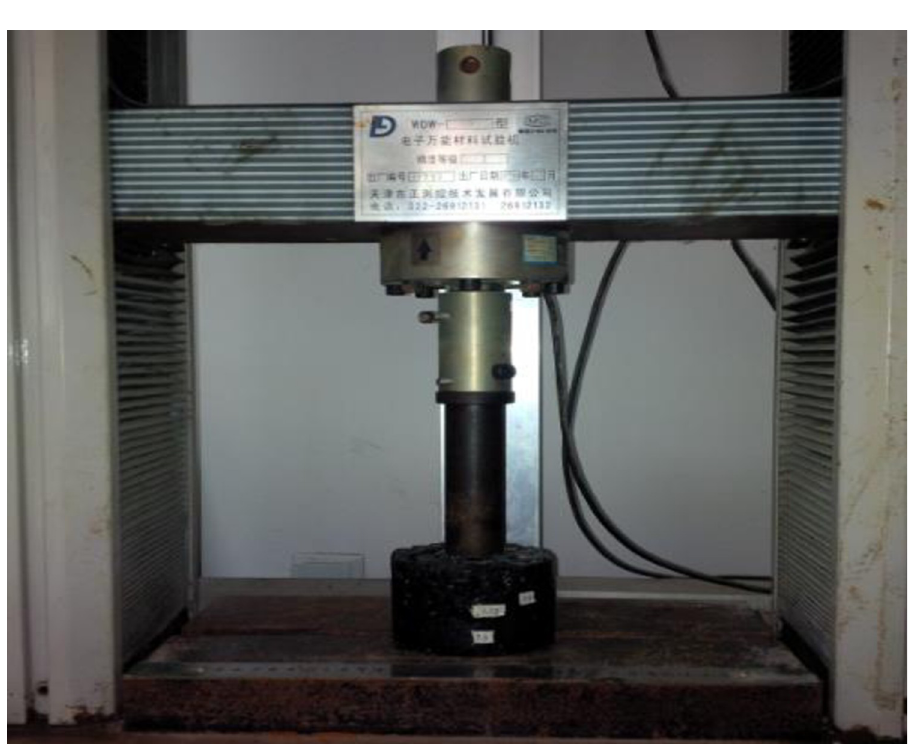
Fig 1. The uniaxial penetration test